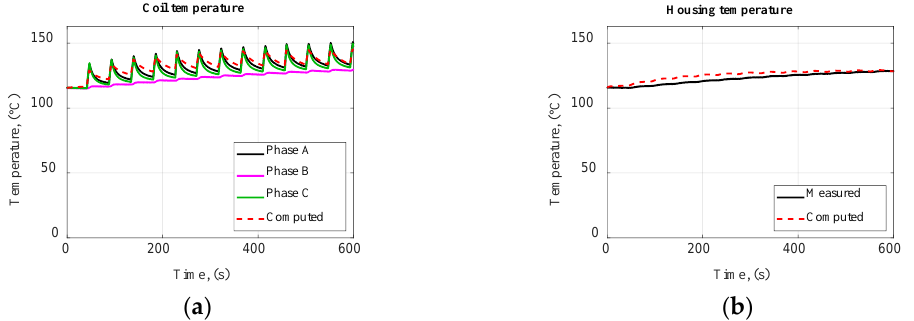
Figure 13. Measured and computed temperatures in the three phases ( a ) and in the housing ( b ) for the load cycle test 2.